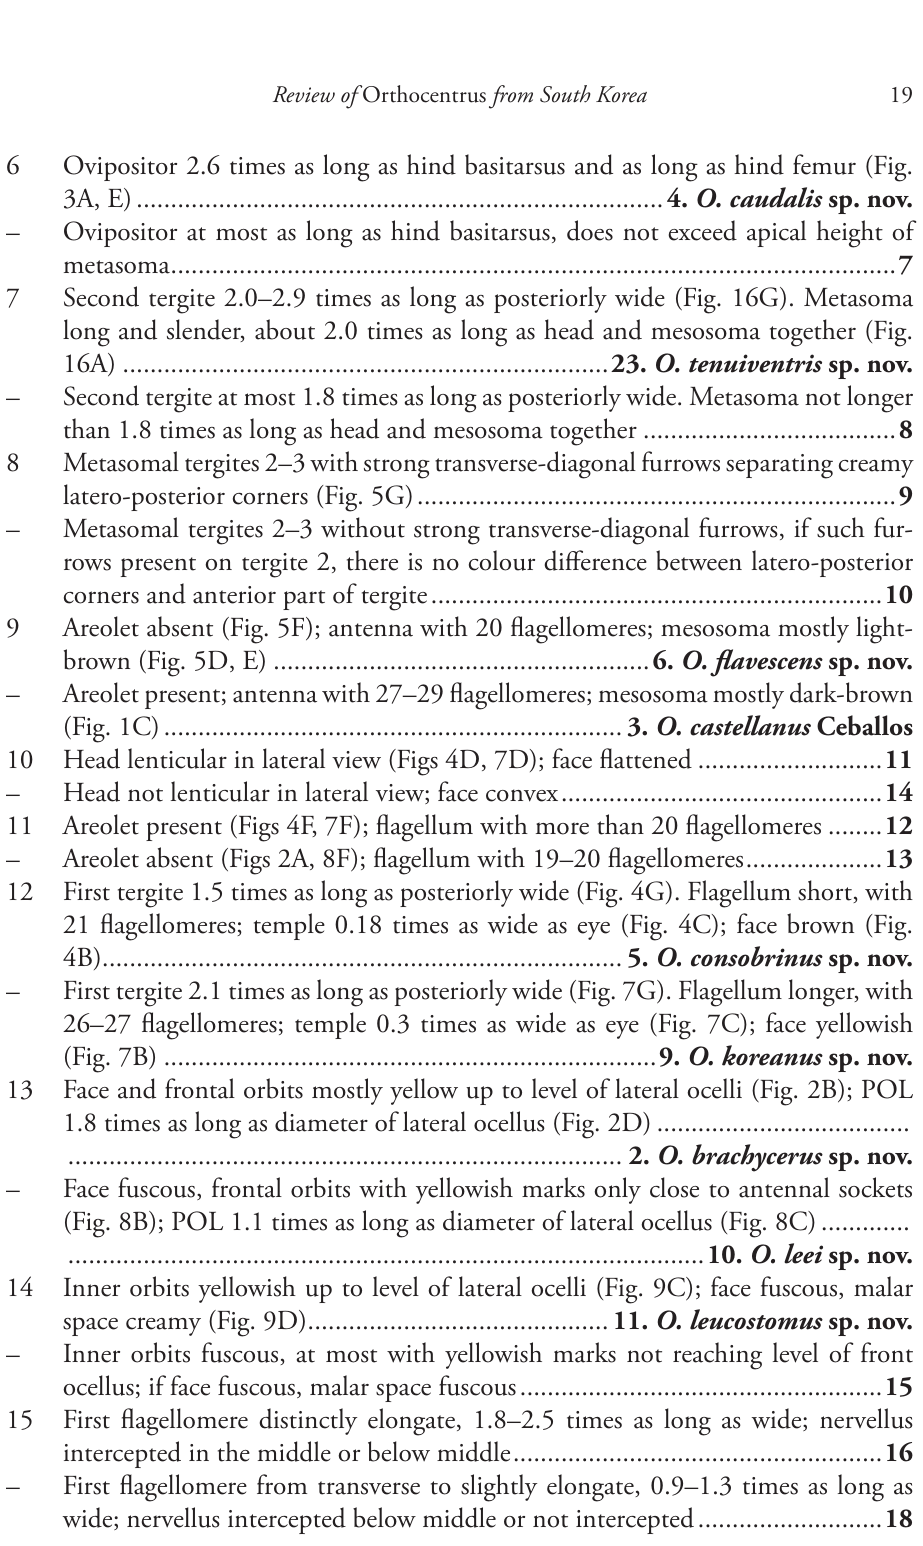
Ovipositor 2.6 times as long as hind basitarsus and as long as hind femur (Fig. – Ovipositor at most as long as hind basitarsus, does not exceed apical height of 7 Second tergite 2.0–2.9 times as long as posteriorly wide (Fig. 16G). Metasoma long and slender, about 2.0 times as long as head and mesosoma together (Fig. – Second tergite at most 1.8 times as long as posteriorly wide. Metasoma not longer than 1.8 times as long as head and mesosoma together ..................................... 8 8 Metasomal tergites 2–3 with strong transverse-diagonal furrows separating creamy latero-posterior corners (Fig. 5G) ...................................................................... 9 – Metasomal tergites 2–3 without strong transverse-diagonal furrows, if such fur- rows present on tergite 2, there is no colour difference between latero-posterior corners and anterior part of tergite .................................................................. 10 9 Areolet absent (Fig. 5F); antenna with 20 flagellomeres; mesosoma mostly light- brown (Fig. 5D, E) ....................................................... 6. O. flavescens sp. nov. – Areolet present; antenna with 27–29 flagellomeres; mesosoma mostly dark-brown (Fig. 1C) ................................................................... 3. O. castellanus Ceballos 10 Head lenticular in lateral view (Figs 4D, 7D); face flattened ........................... 11 – Head not lenticular in lateral view; face convex ............................................... 14 11 Areolet present (Figs 4F, 7F); flagellum with more than 20 flagellomeres ........ 12 – Areolet absent (Figs 2A, 8F); flagellum with 19–20 flagellomeres .................... 13 12 First tergite 1.5 times as long as posteriorly wide (Fig. 4G). Flagellum short, with 21 flagellomeres; temple 0.18 times as wide as eye (Fig. 4C); face brown (Fig. – First tergite 2.1 times as long as posteriorly wide (Fig. 7G). Flagellum longer, with 26–27 flagellomeres; temple 0.3 times as wide as eye (Fig. 7C); face yellowish (Fig. 7B) ........................................................................ 9. O. koreanus sp. nov. 13 Face and frontal orbits mostly yellow up to level of lateral ocelli (Fig. 2B); POL 1.8 times as long as diameter of lateral ocellus (Fig. 2D) ..................................... – Face fuscous, frontal orbits with yellowish marks only close to antennal sockets (Fig. 8B); POL 1.1 times as long as diameter of lateral ocellus (Fig. 8C) ............. 14 Inner orbits yellowish up to level of lateral ocelli (Fig. 9C); face fuscous, malar space creamy (Fig. 9D) ............................................ 11. O. leucostomus sp. nov. – Inner orbits fuscous, at most with yellowish marks not reaching level of front ocellus; if face fuscous, malar space fuscous ..................................................... 15 15 First flagellomere distinctly elongate, 1.8–2.5 times as long as wide; nervellus intercepted in the middle or below middle ...................................................... 16 – First flagellomere from transverse to slightly elongate, 0.9–1.3 times as long as wide; nervellus intercepted below middle or not intercepted ...........................